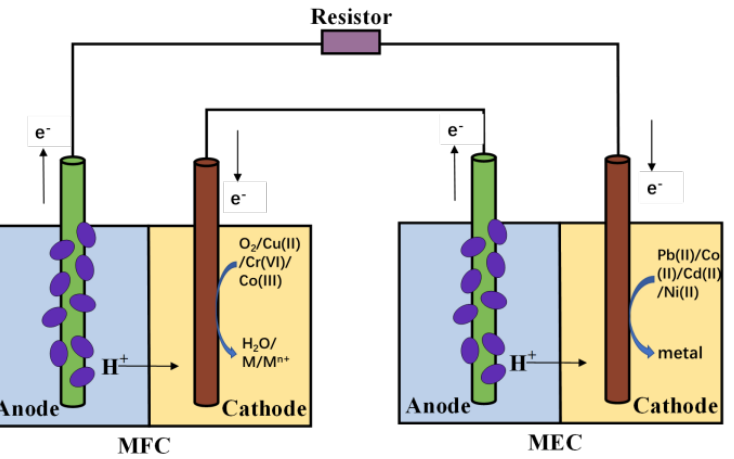
Figure 3. The illustration of the MFC–MEC coupling system. In this MFC–MEC coupling system, the species including metal ions and oxygen with higher oxidation potential are usually processed in the MFC, while the metal ions with a lower oxidation potential are usually treated in the MEC. Both the MFC and MEC can employ metal ions as the electron acceptors. Luo et al. constructed an MFC–MEC coupling system, in which the MFC was used to reduce Cu(II) and generate a bias voltage, and the bias voltage was applied directly to the MEC to reduce Ni(II) [59]. In Luo’s system, wastewater containing copper and wastewater containing nickel could be simultaneously treated, with efficient copper and nickel recovery, respectively. Huang et al. constructed an MFC–MEC coupling system to recover cobalt [60]. The MFC was used to reduce Co(III) to Co(II) with bias voltage generation, while the MEC was used to further reduce Co(II) to metal cobalt. Thus, in this MFC–MEC coupling system, Co(III) in LiCoO 2 can be recovered as metal cobalt, and this system is promising for lithium battery recycling. Similar configurations were also constructed to treat wastewater containing Cu(II)/Co(II) [61], Cr(VI)/Cu(II)/Cd(II) [62], Cu(II)/Co(II)/Li(I) [63], Cu(II)/Cd(II) [64], and Cr(VI)/Pb(II) [65,66]. In these studies, the reaction conditions and cathode materials could be optimized to improve the coupling systems’ performance. In addition, there are also a few MFC–MEC coupling systems in which the MFC employs oxygen as an electron acceptor while the MEC employs heavy metal ions as the electron acceptor